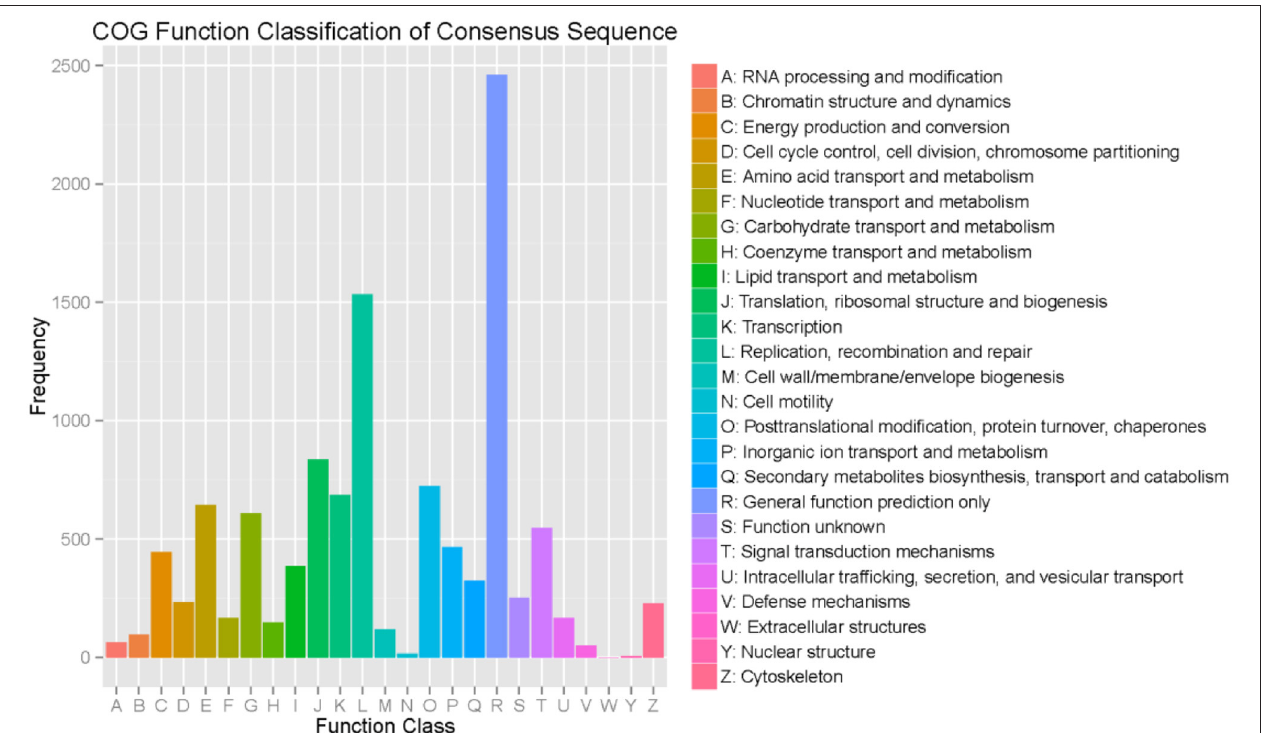
FIGURE 3 | Functional classifications based on the Clusters of Orthologous Groups protein database.